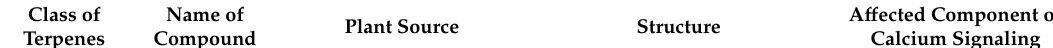
Table 1. Classification, structures, and action of terpenes and terpenoids described in this